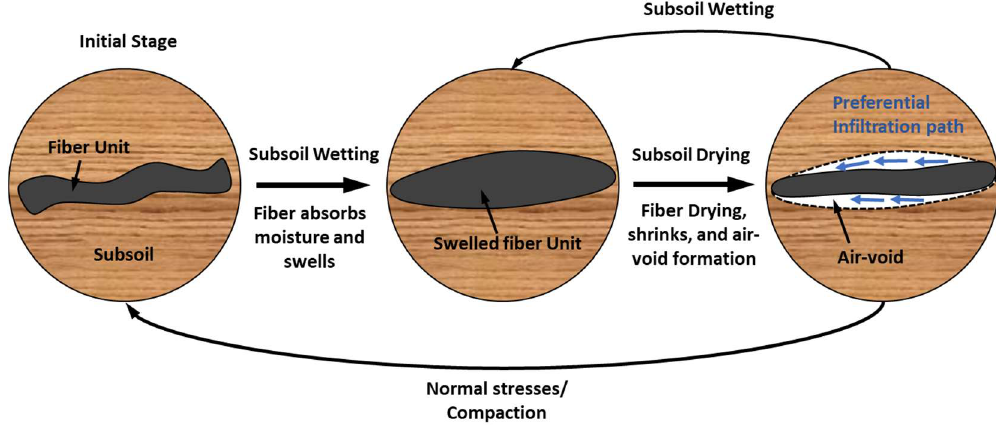
Figure 7. Schematic illustration of the shrink-swell cycles of fiber at subsoil condition and formation of infiltration path along interface voids.